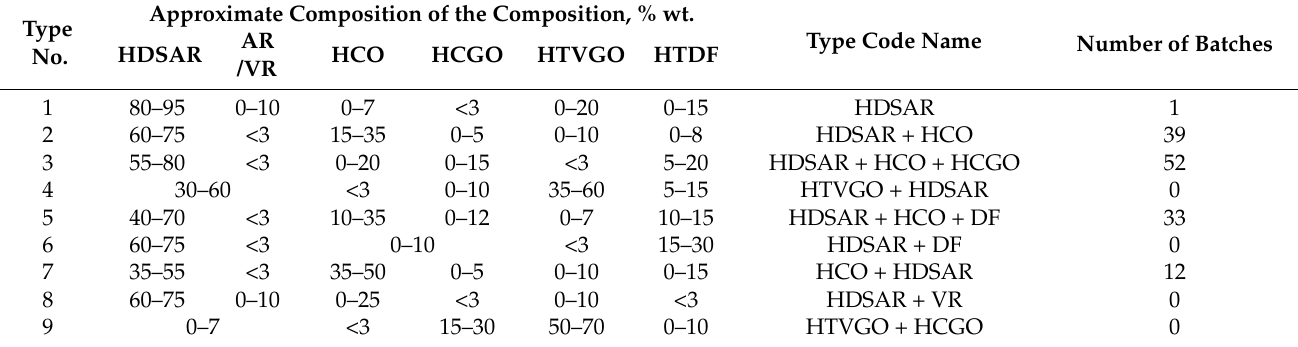
Table 10. Distribution of shipments in the port of Hong Kong by type [80].